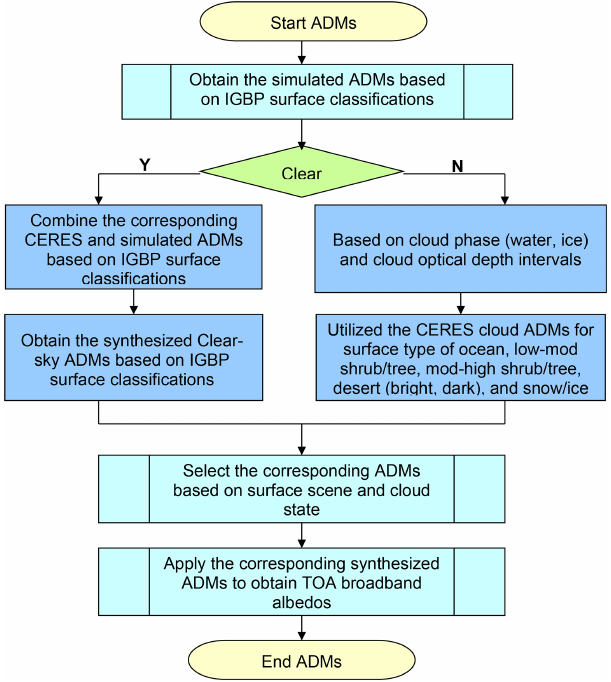
Figure 2. Schematic illustration of the logic employed to synthesize modeled and observed